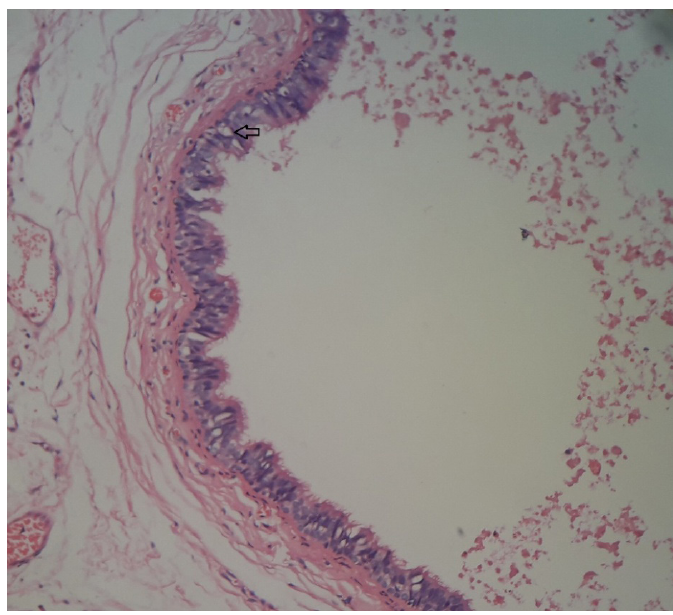
Figure 3 (b): Histopathological section of a cyst wall demonstrating goblet